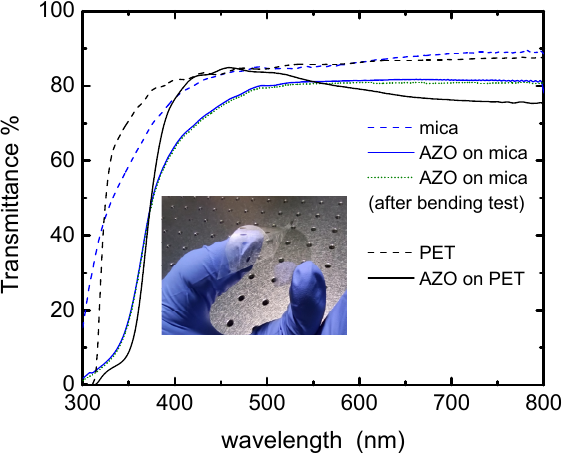
Figure 4. Transmittance spectra of AZO on mica and AZO on PET substrates. Transmittance spectra of mica and PET blank substrates are shown for reference (dash lines), as well as AZO on mica after bending (dot line). Inset image-photograph of AZO on mica substrate.